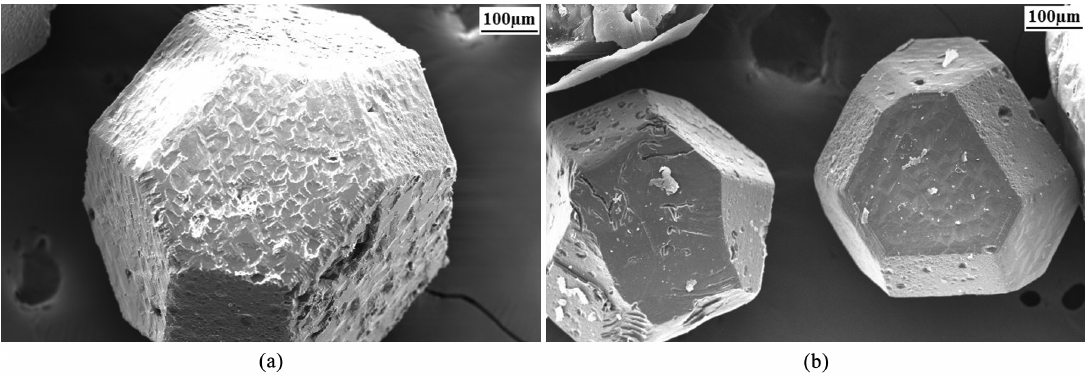
Figure 12. Diamonds (a) without covering and (b) with Ti coating, after heat treatment of 360 min.